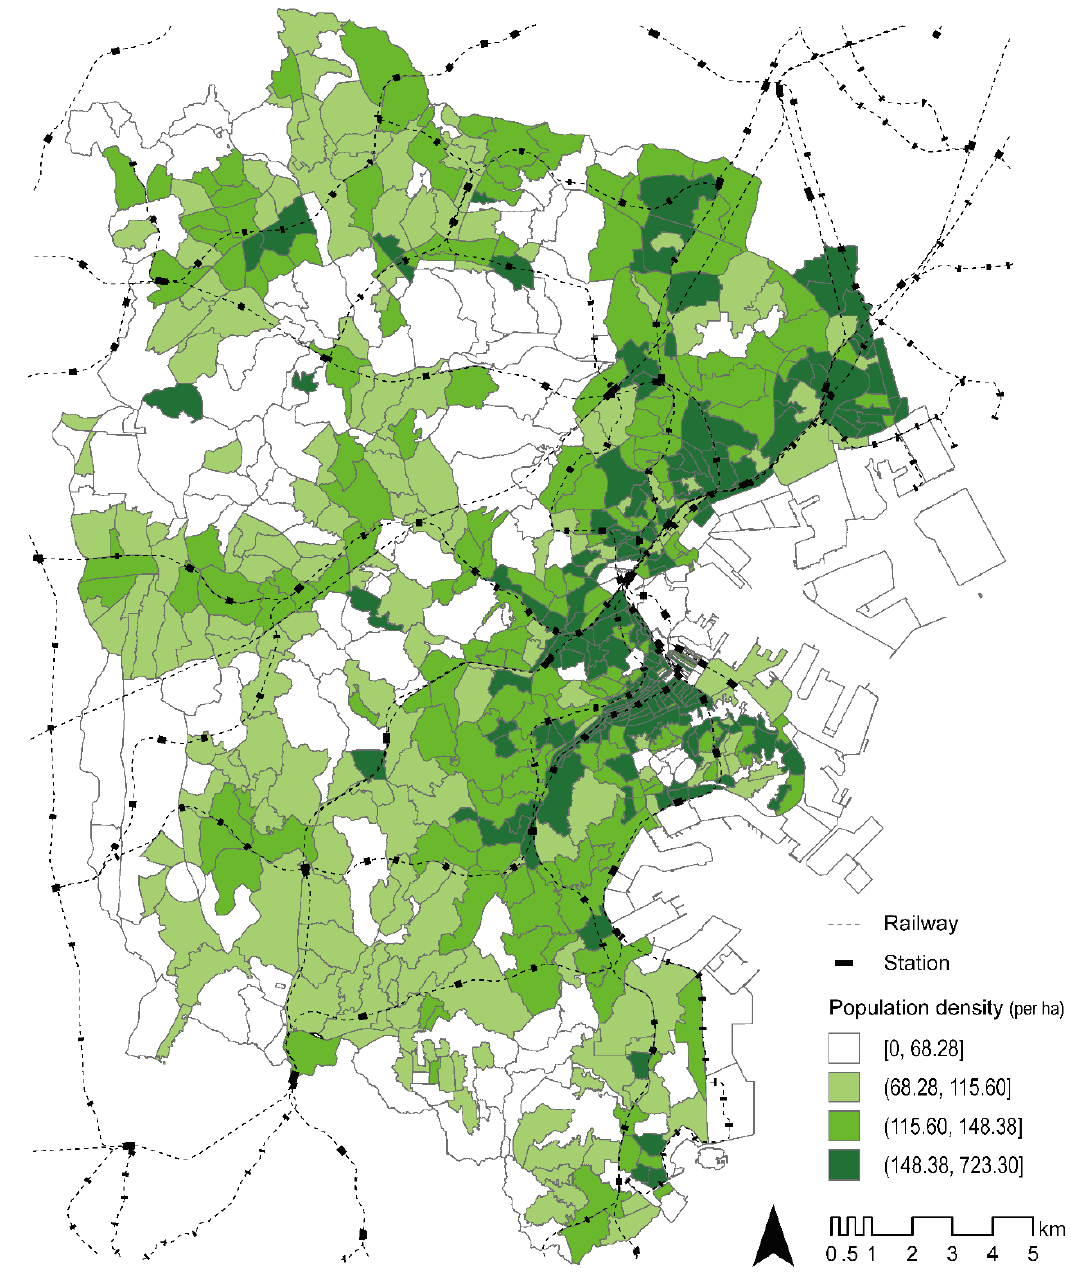
Figure 1. Target area (Yokohama City).